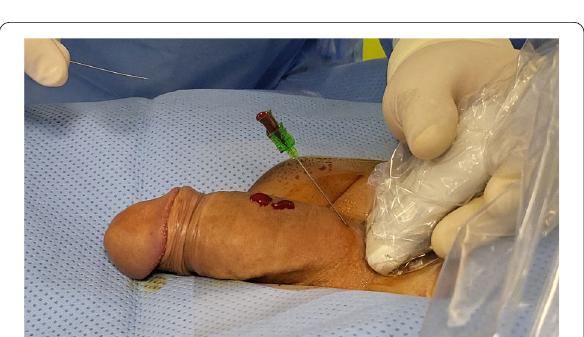
Fig. 3 A An 0.018-inch guide wire is inserted into the needle hub and carefully advanced as long as there is no resistance.